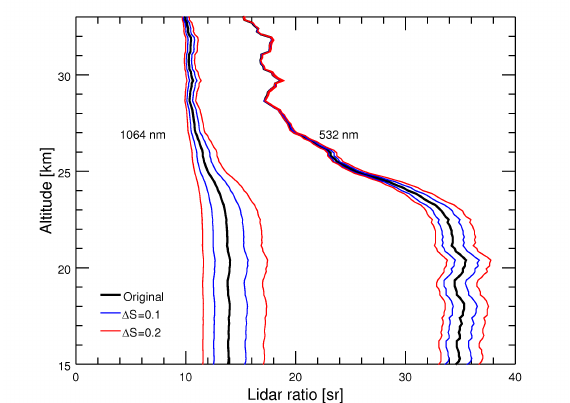
Figure 11. Extinction coefficient profiles ( k sca ) for March 2013 inferred with an assumed distribution width Mie of S = 1.5 (Original) with total error ranges of the two assumed deviations ( ∆ S ) of the distribution width.